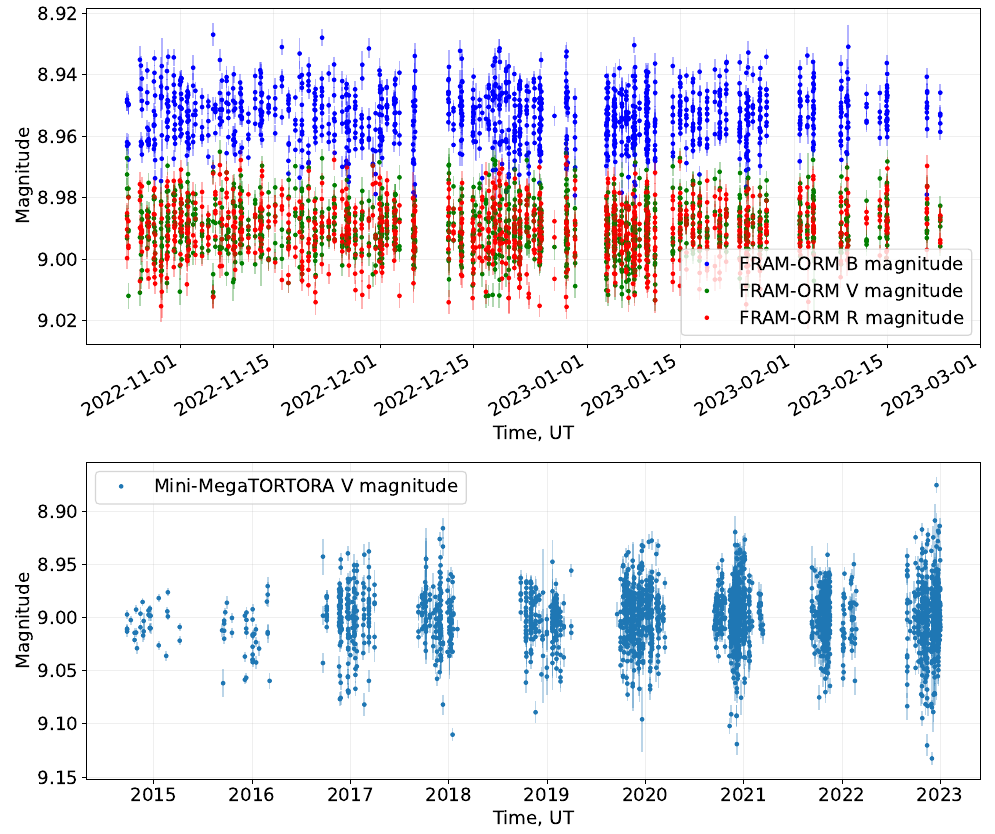
Figure 8. Light curves of HD36030 from FRAM-ORM ( upper panel ) and Mini-MegaTORTORA ( lower panel ). FRAM-ORM observed the star in three Johnson–Cousins photometric filters, whereas Mini-MegaTORTORA data are in white light and re-calibrated to Johnson V bandpass. Both light curves lack any signs of systematic variability or statistically significant